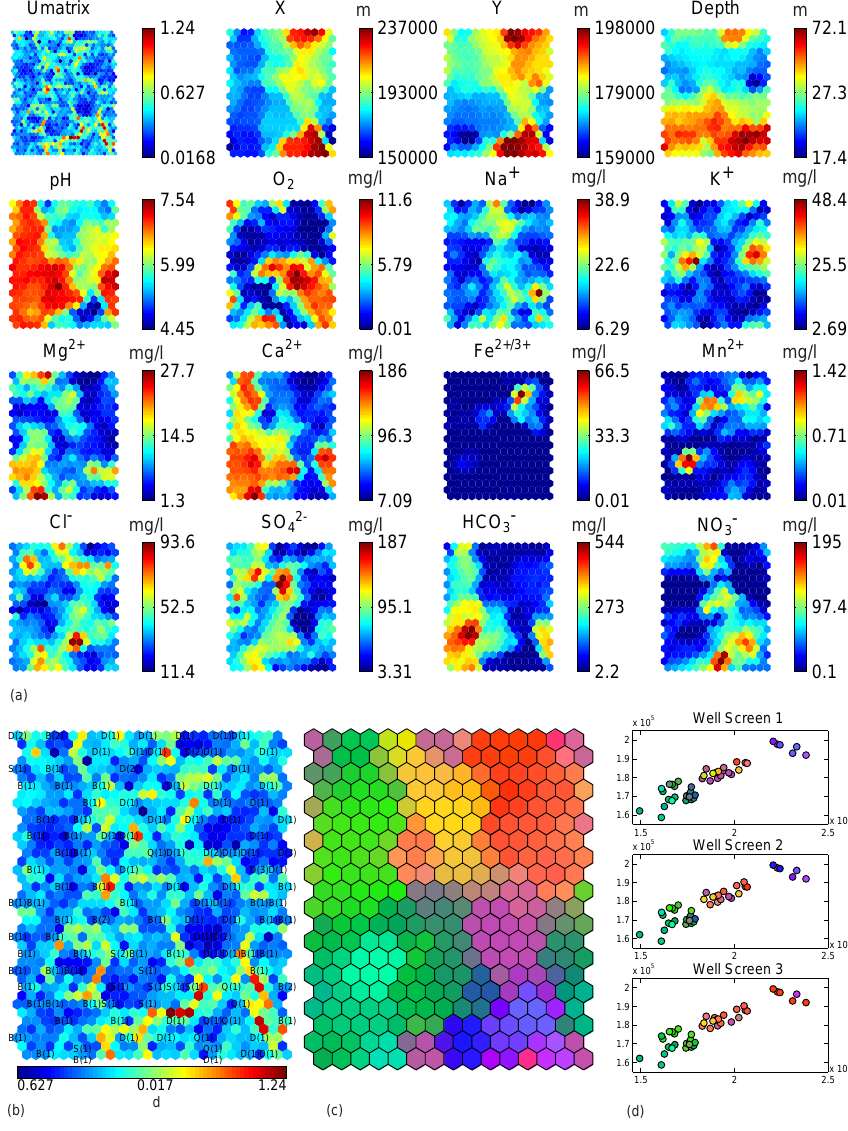
Fig. 9. Results of the GEO3DSOM-analysis of the hydrochemical data set. (a) U-matrix and component planes (b) labeled U-matrix (c) false coloring of U-matrix (d) spatial distribution of well screens, using false